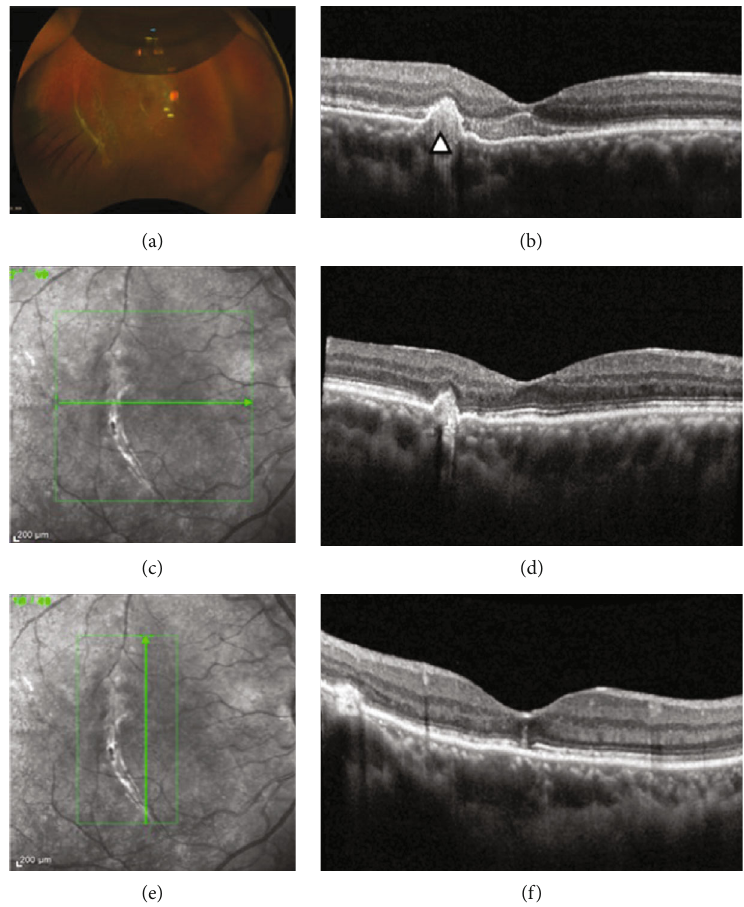
Figure 2: (a) Six weeks after surgery. The 20% remaining per fl uoropropane (C laser. (b) The 6-week spectral-domain optical coherence tomography (SD-OCT) corresponding to the submacular hemorrhage is almost completely reabsorbed. The IS/OS and external limiting membrane (ELM) lines show irregularity and are compacted against the protruded hyperre fl ective retinal pigment epithelium (arrowhead). The retinal pigment epithelium shows bulging without rupture but only mild disruption and fused IS/OS with the ELM (c, d). The 6-month postoperative cross-sectional horizontal and (e, f) vertical planes through the foveal center on